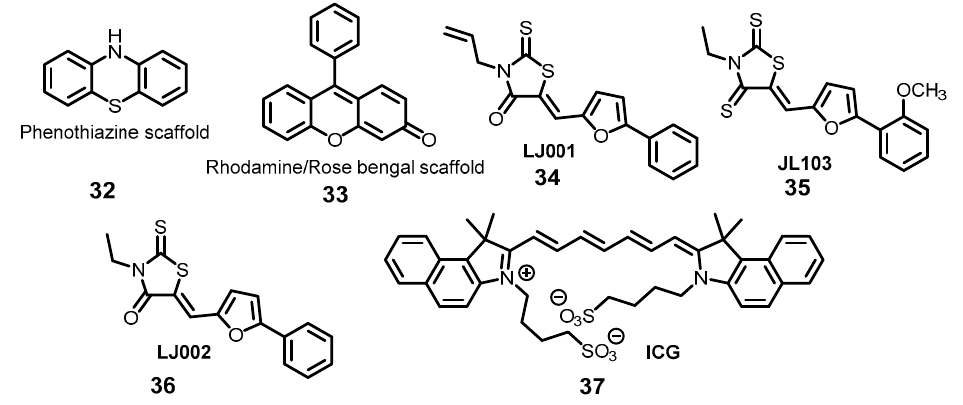
Figure 9. Other aromatic antiviral photosensitizers.